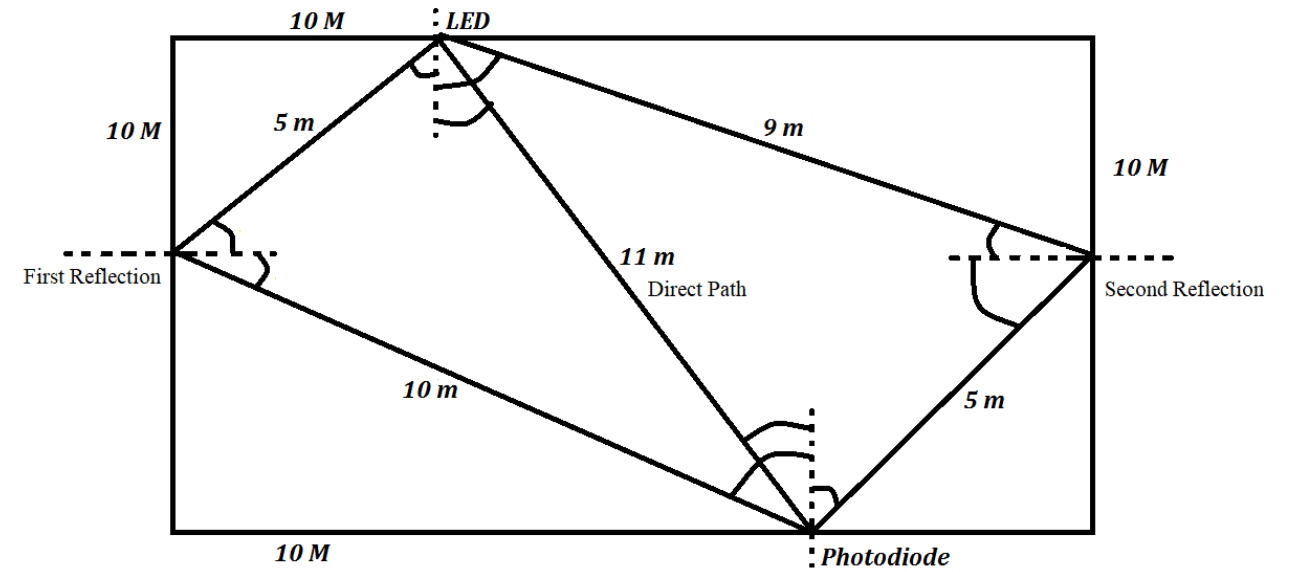
Figure 20. Example of a single LED NLOS propagation